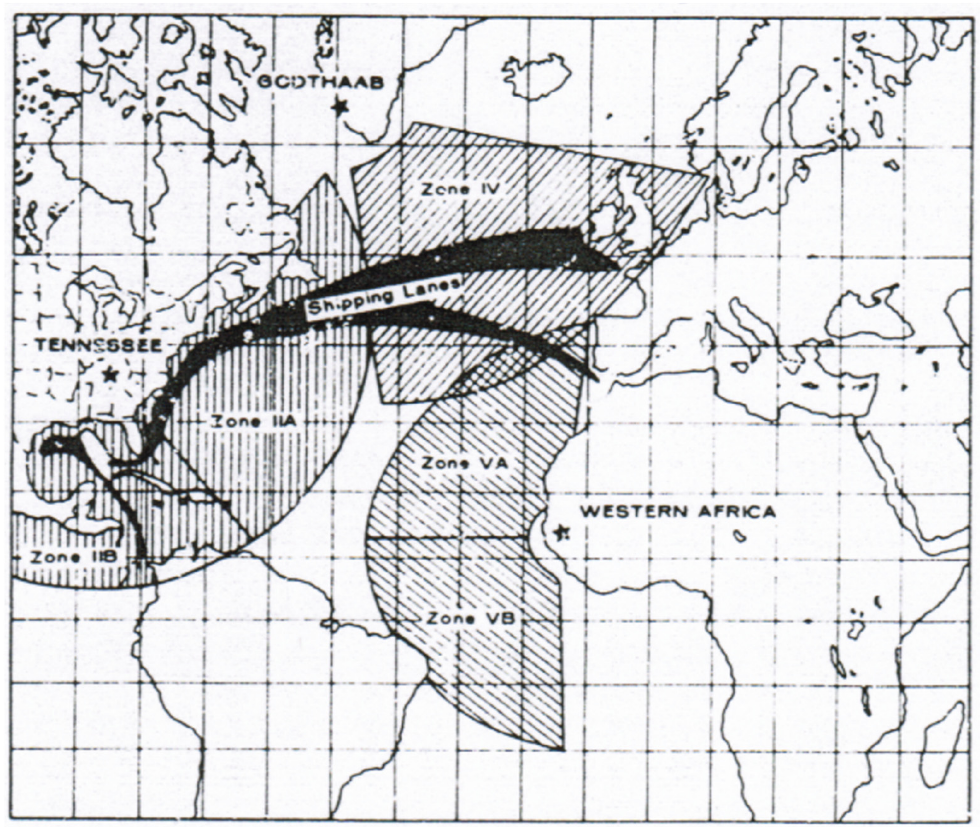
Figure 25. Proposed sites and nominal coverage for Pacific radars envisaged by Rhodes and Chad- wick [101].